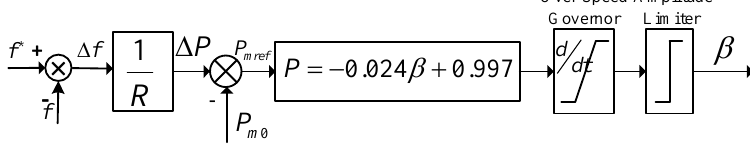
Figure 5. Schematic diagram of the accessional pitch angle control.